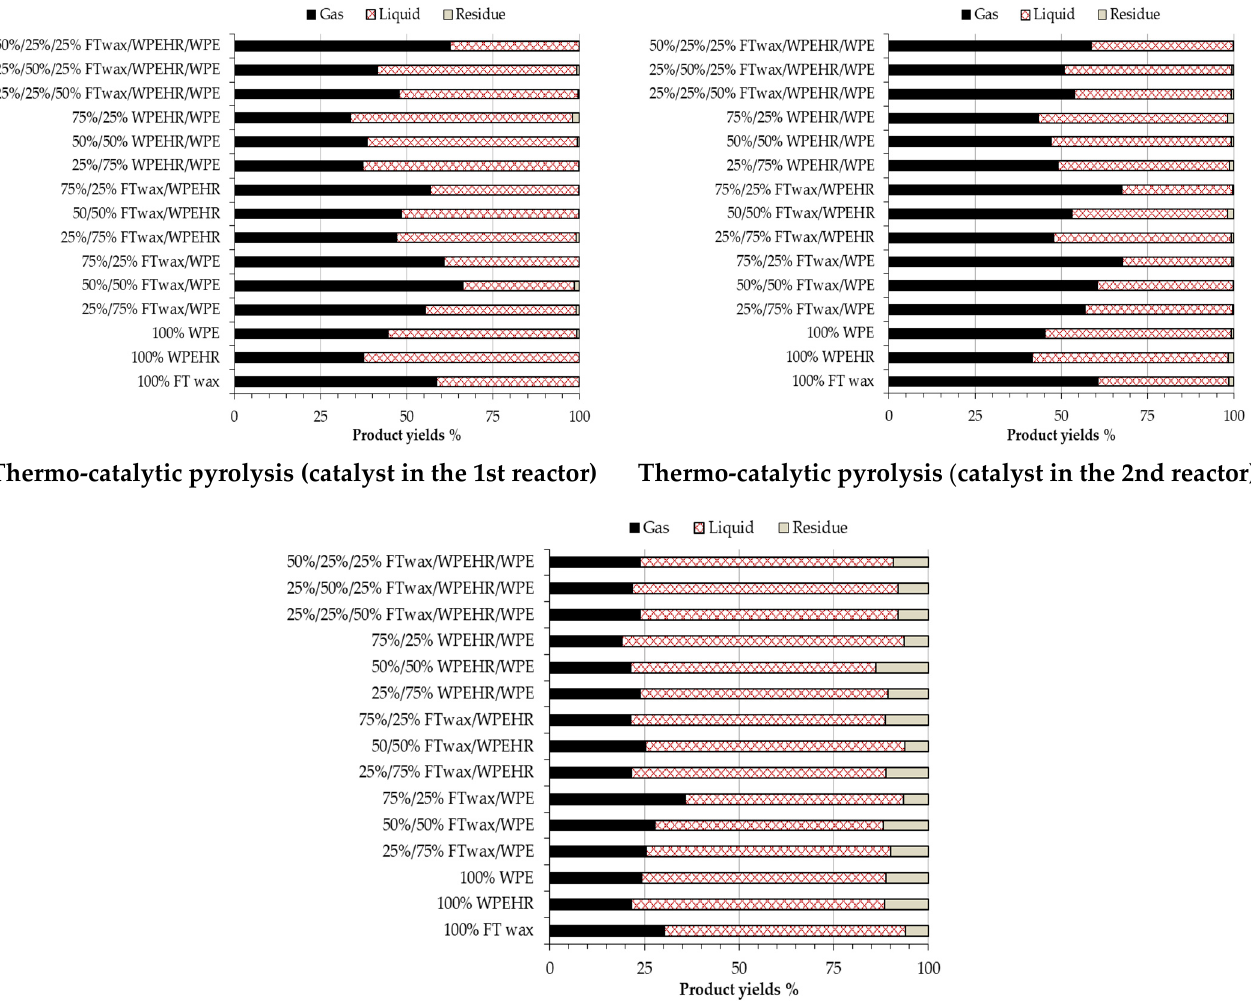
Figure 2. Product yields of pyrolysis.